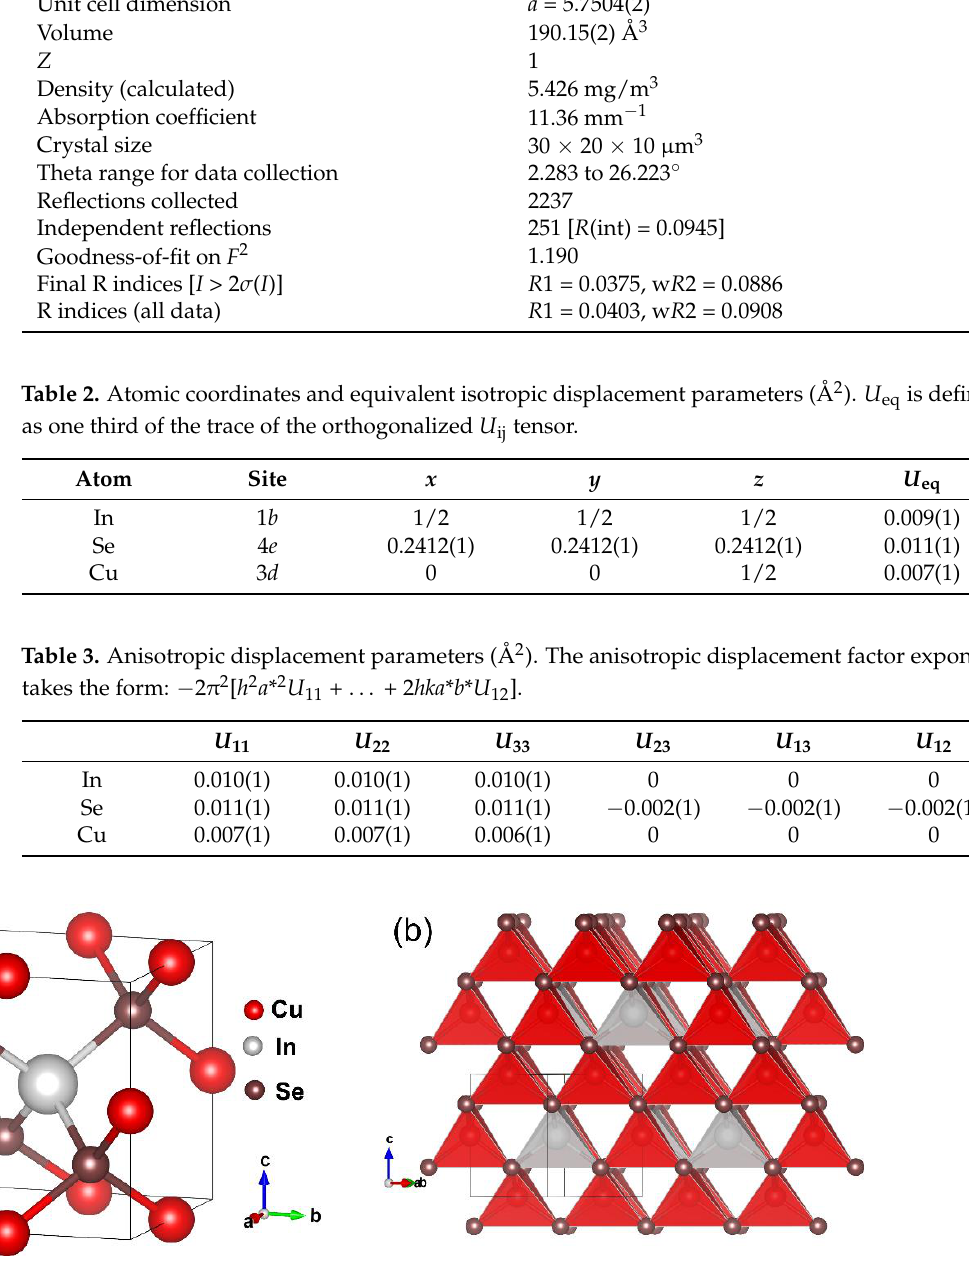
Figure 1. Schematic illustrating the crystal structure of Cu 3 InSe 4 showing the ( a ) unit cell and ( b ) stacking of the CuSe 4 (red) and InSe 4 (gray) tetrahedra. Table 1. Crystal data and structure refinement results.